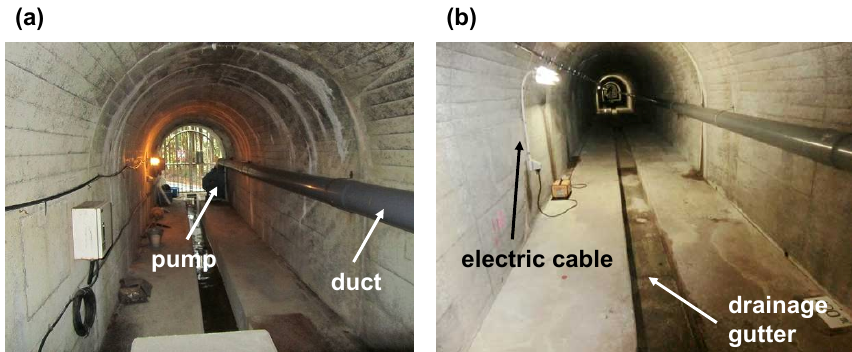
Fig. 2. Photograph of the infrastructure equipped in the drainage tunnel: (a) a turbofan exhaust duct, and (b) commercially available monophase 200V electricity and the drainage gutter.